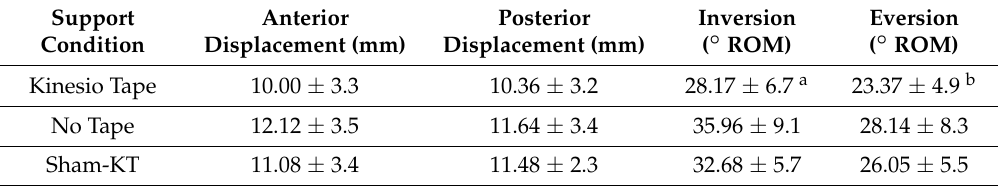
Table 1. Arthrometric Measurements of Passive Ankle Complex Motion by Support